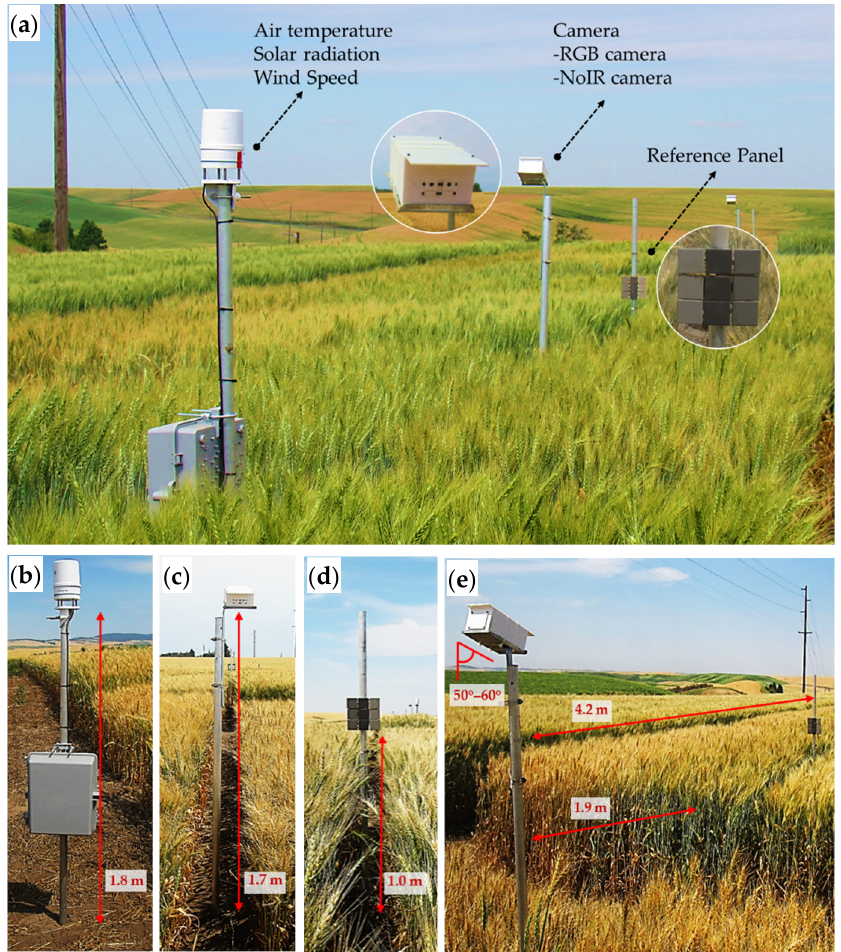
Figure 4. Sensor system and associated components. ( a ) Complete sensor set-up, ( b ) the weather station installed at 1.8 m AGL, ( c ) the sensor system installed at 1.7 m AGL, ( d ) the reference panel installed at 1.0 m AGL, and ( e ) the sensor system angle (50–60° downward) installed at a distance of 4.2 m between the sensor system and the reference panel and 1.9 m between the sensor system and targeted plot boundary.